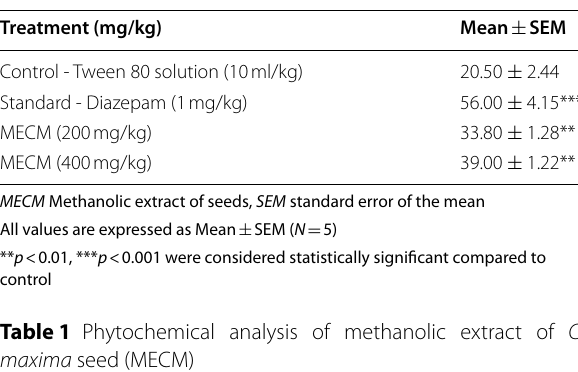
Table 2 Effect of MECM on head dipping of Swiss Albino mice in Hole-board